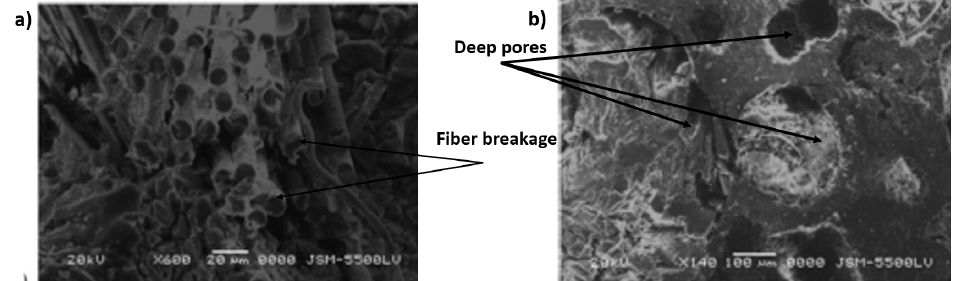
Figure 10. GRP SEM images: ( a ) fiber, ( b ) matrix.